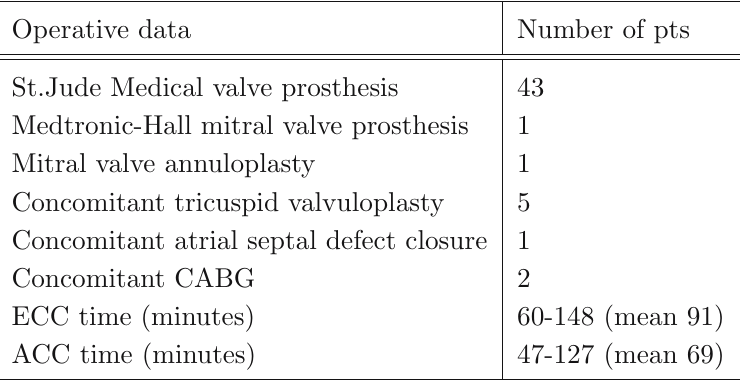
Fig. 1 Pulmonary veins isolation. Table 2 Summarised surgical